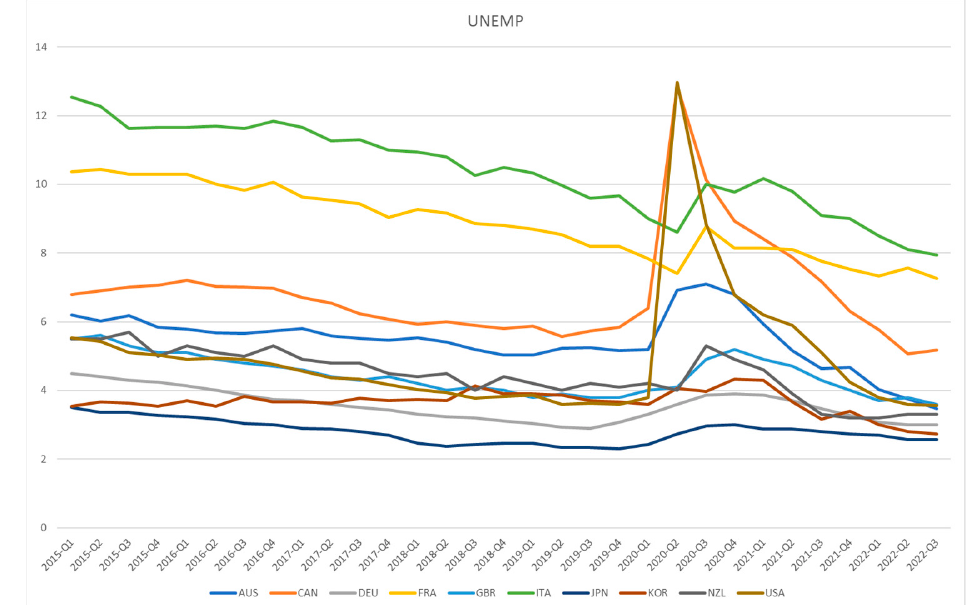
Figure 5. Unemployment rates of ten countries from 2015 Q1 to 2022 Q3. Source: data from OECD (2022a) [36]. Legend: Australia (AUS), Canada (CAN), Germany (DEU), France (FRA), Great Britain (GBR), Italy (ITA), Japan (JAP), South Korea (KOR), New Zealand (NZL), and the United States of America (USA).